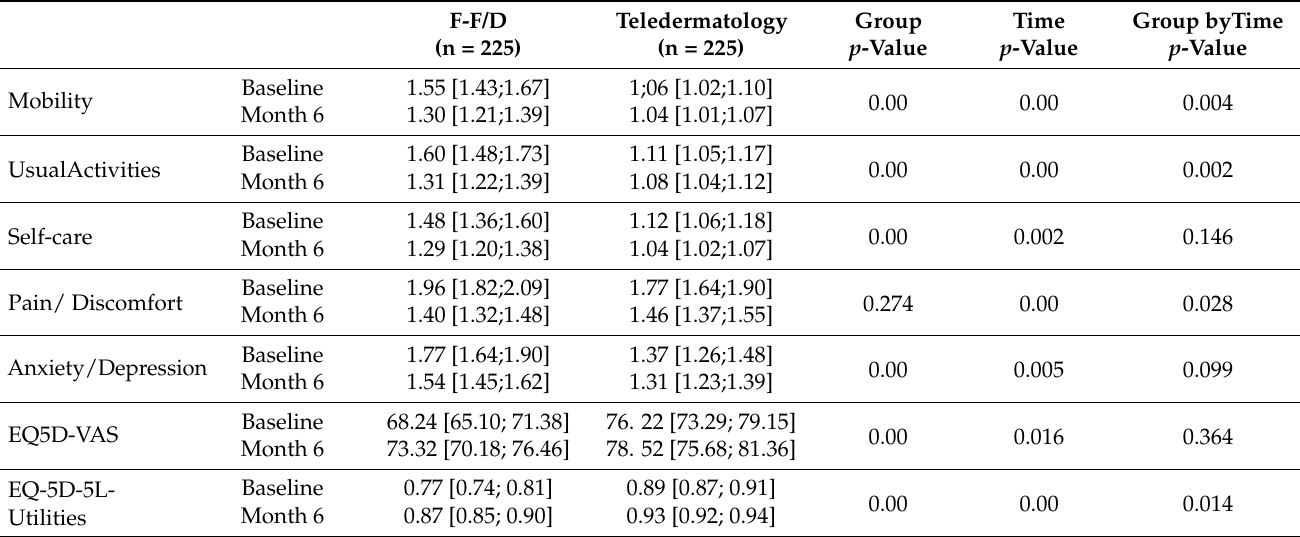
Table 5. Repeated measures design with group and time as fixed effects across EQ5D.